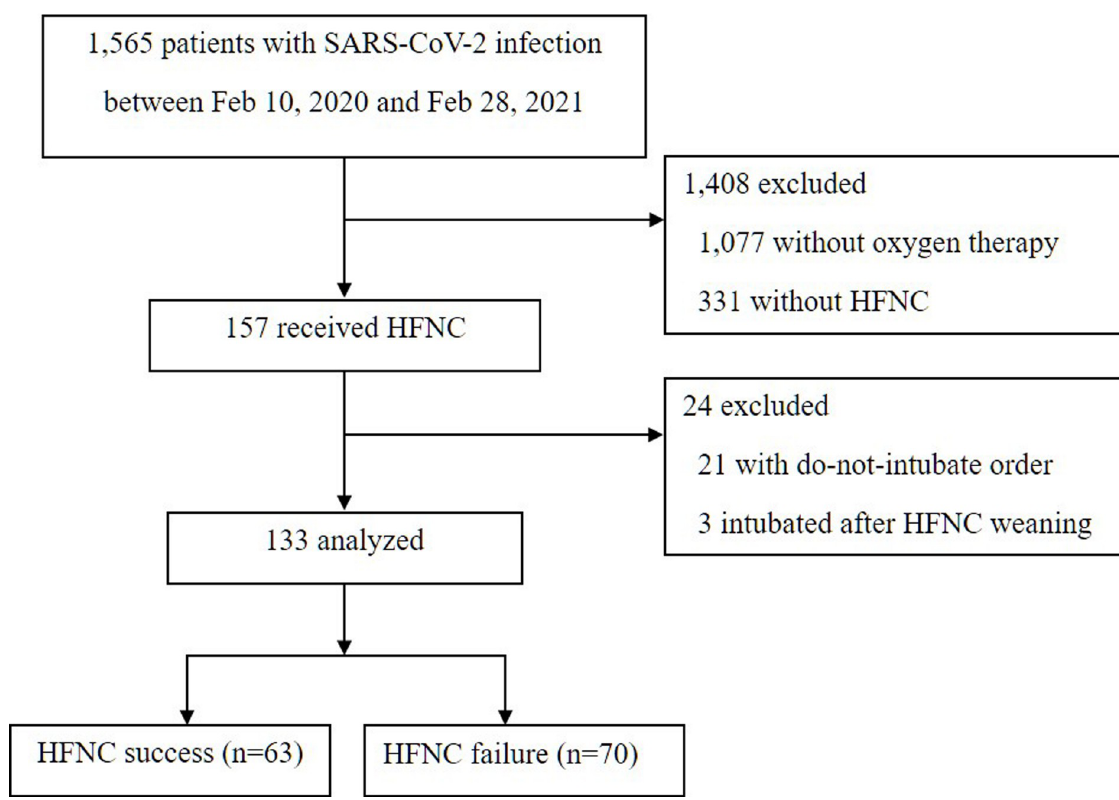
Fig 1. Flowchart of patients with SARS-CoV-2 infection. SARS-CoV-2, severe acute respiratory syndrome coronavirus 2; and HFNC, high- flow nasal cannula.